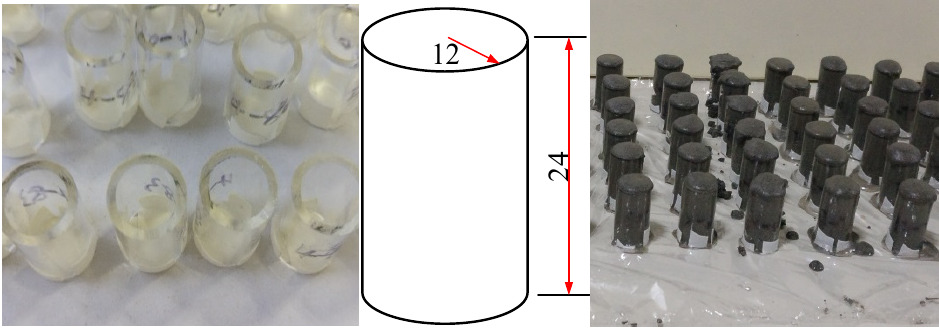
Figure 2. Specimen geometry and physical parameters.